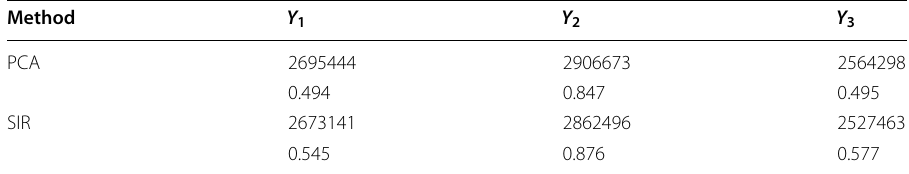
Table 4 BIC and adjusted R 2 values for each of the additive model fits using the trans- formed predictors from PCA and